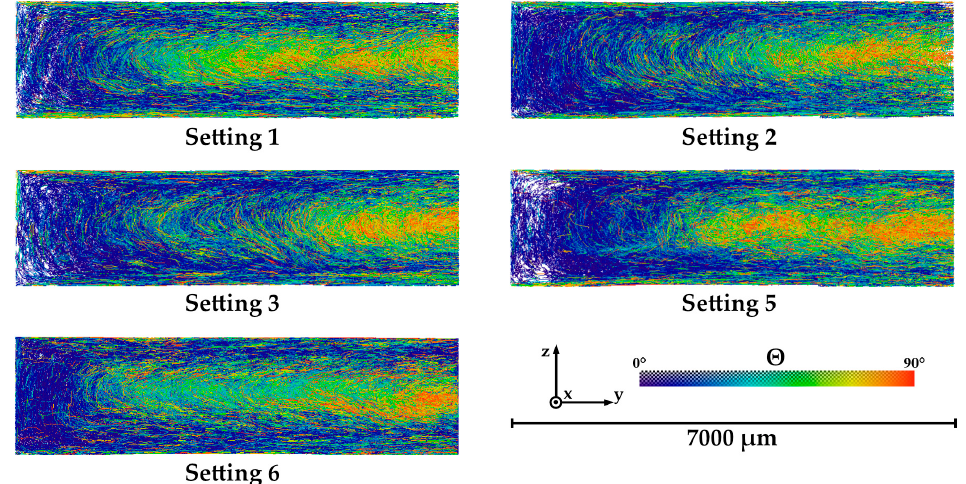
Figure 9. Illustrations of fiber orientations of RCF reinforced specimens produced with open hot runner system obtained by fiber tracing evaluation of the µCT data.